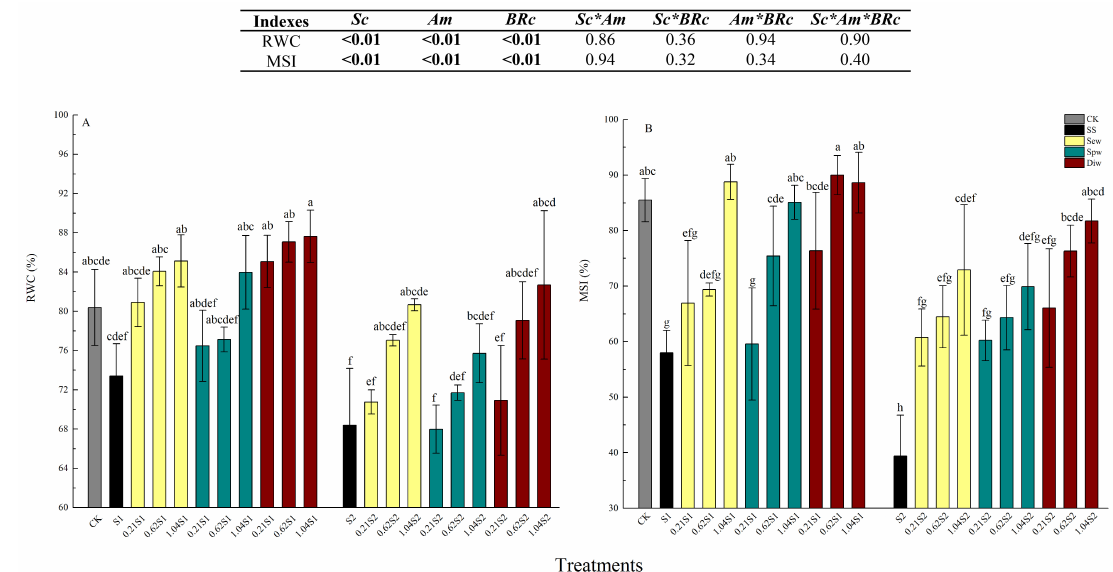
Figure 3. Effects of exogenous 24-epiBL on ( A ) relative water content (RWC) and ( B ) membrane stability index (MSI) of leaves of black locust seedlings at 100 (SS-S1) or 200 (SS-S2) mM NaCl. Other details as